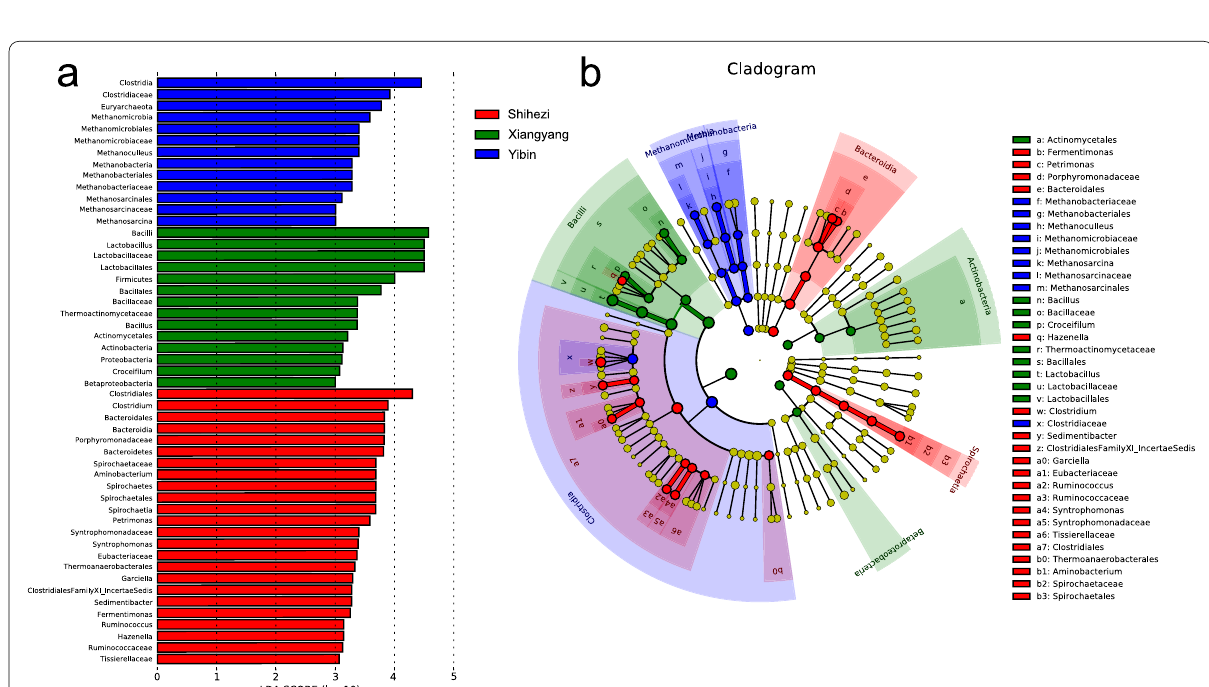
Fig. 4 Identification of discriminant prokaryotes among different distillery by LEfSe analysis. LDA scores computed for taxa differentially abundant between different regions ( a ) and cladogram exhibiting the evolutionary relationship of taxa with differentially abundant ( b